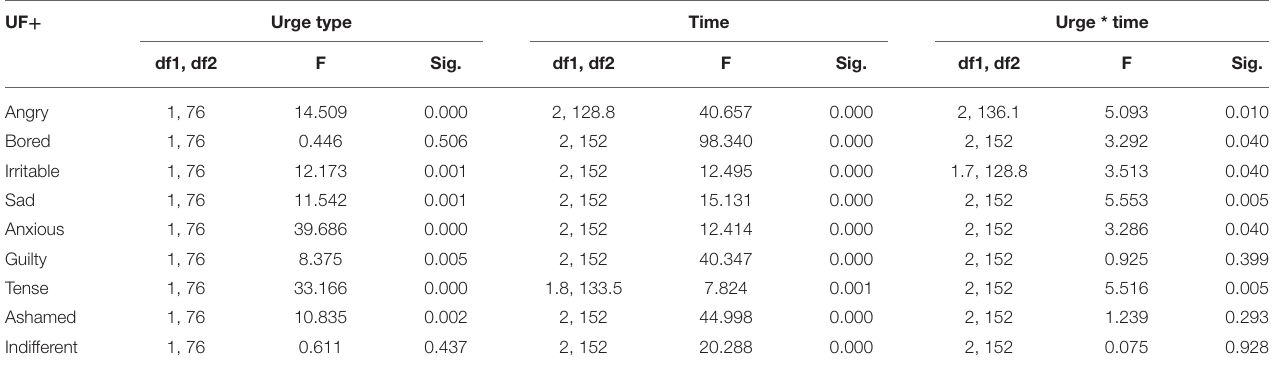
TABLE 2 | Main effects of urge type, time, and urge type * time interaction for nine affective states. UF +